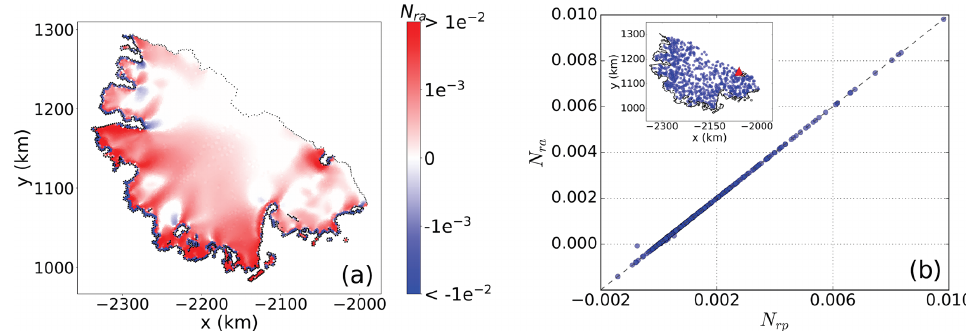
Figure 12. (a) Grounding-line flux sensitivity for the Larsen C domain derived from the adjoint model approach. (b) Perturbation- ( N rp ; x axis) versus adjoint-based ( N ra ; y axis) sensitivities plotted against one another (perturbation locations are shown by circles in the inset, where the one outlier in b is at the calving front – red triangle – and the grounding-line grid cells in map view are shown by the black